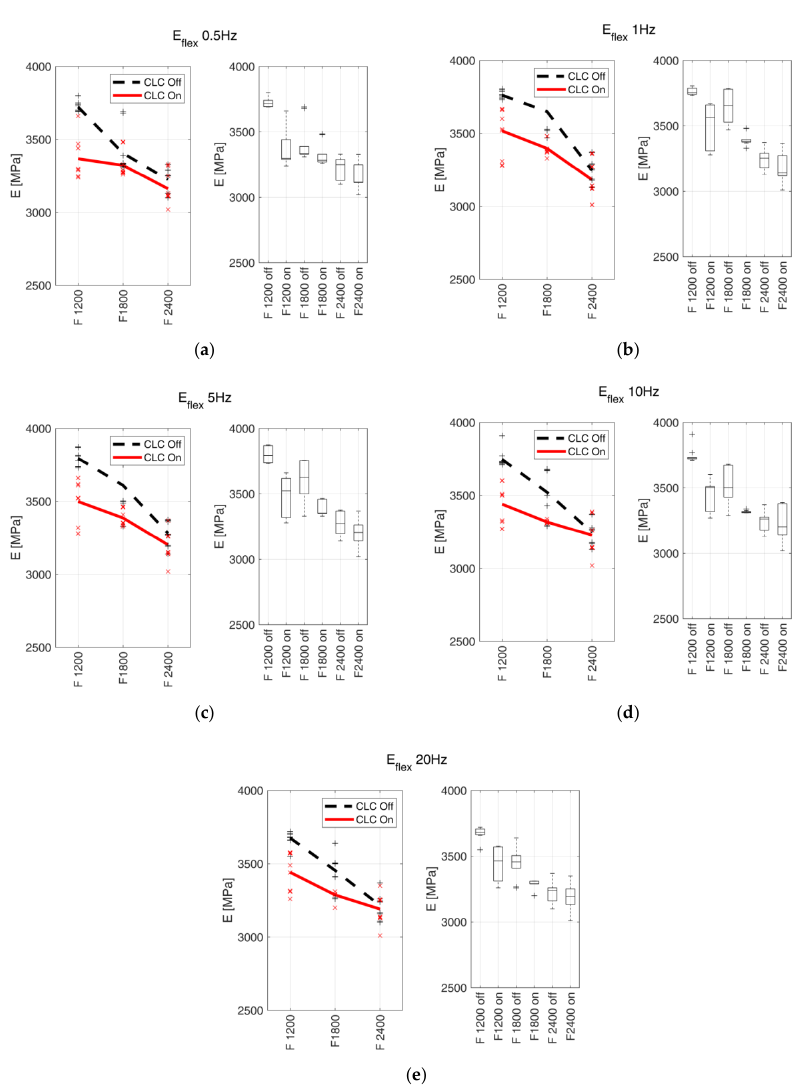
Figure 10. E flex measured through DMA and relative boxplots at ( a ) 0.5 Hz, ( b ) 1 Hz, ( c ) 5 Hz, ( d ) 10 Hz and ( e ) 20 Hz. Markers indicate the measured values, and bold lines indicate the mean values. The continuous red line indicates the samples realised with enabled CLC, and the black dashed line indicates the samples realised with disabled CLC.